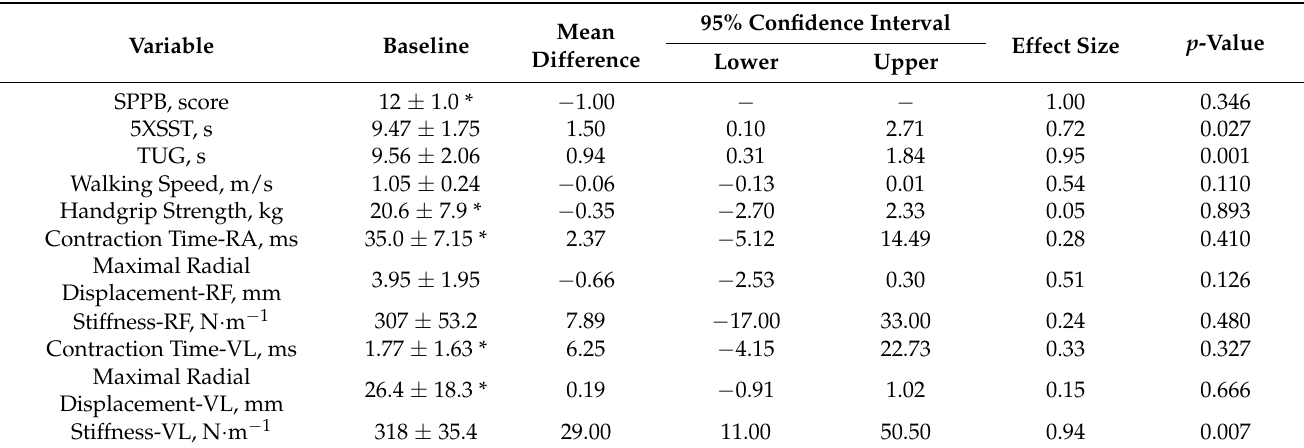
Table 2. Difference between baseline and post